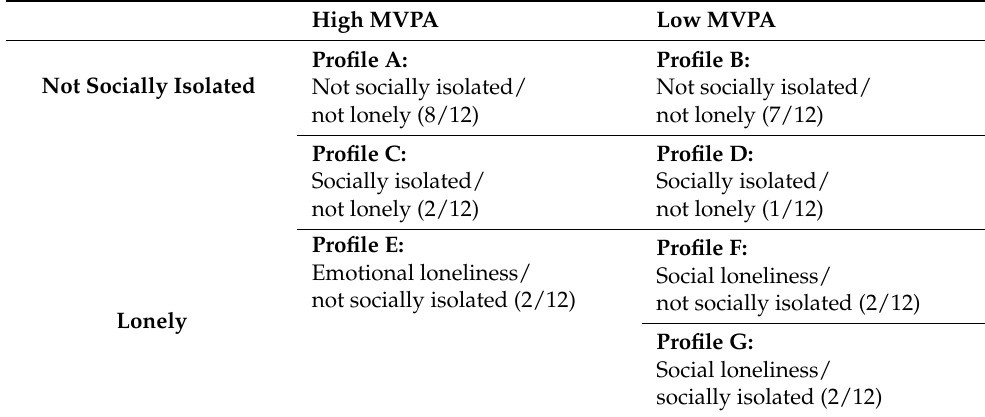
Table 3. Seven profiles of moderate-to-vigorous physical activity (MVPA), social isolation and